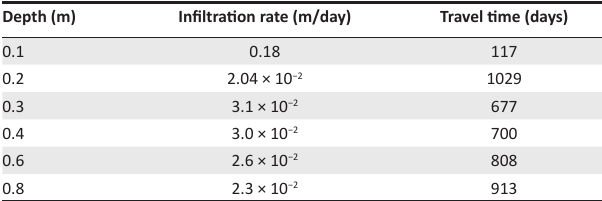
FIGURE 5: (a–f) Simulated soil moisture fluxes with depth for probe TABLE 4: Computed travel time for each depth increment for probe 17434.